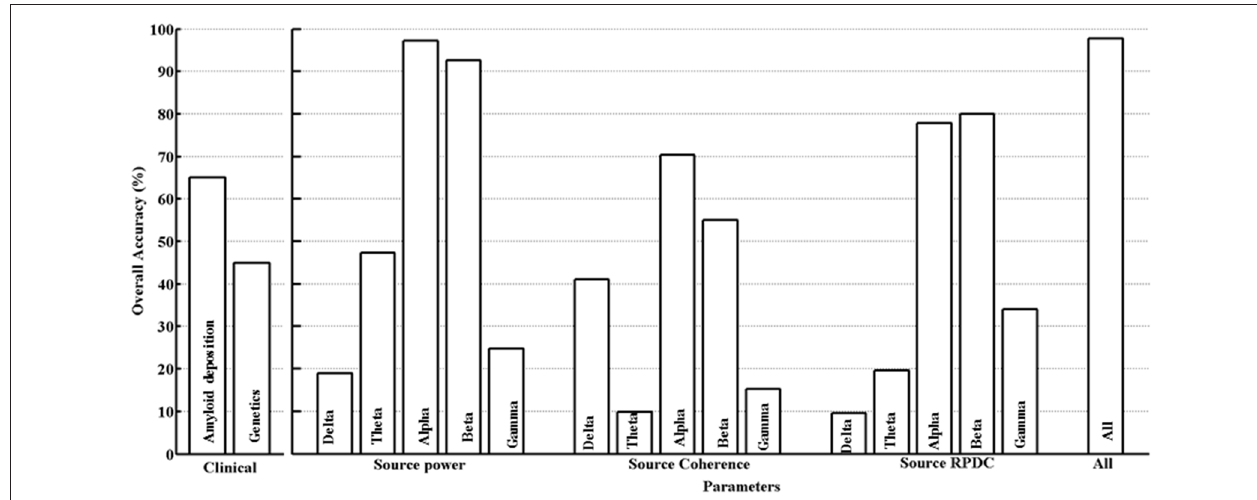
FIGURE 3 | Support vector machine (SVM) classification results.